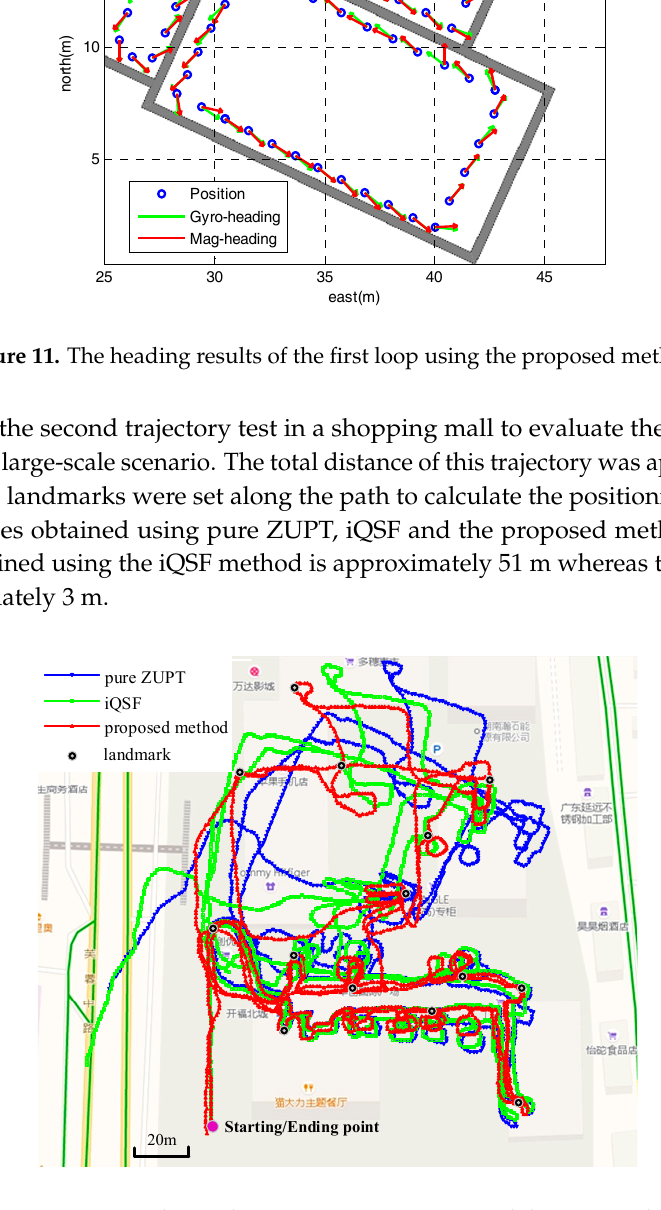
Figure 10. The step-wise trajectories of the office test: ( a ) Step-wise trajectory of the pure ZUPT method; ( b ) Step-wise trajectory of the iQSF method; ( c ) Step-wise trajectory of the proposed method.